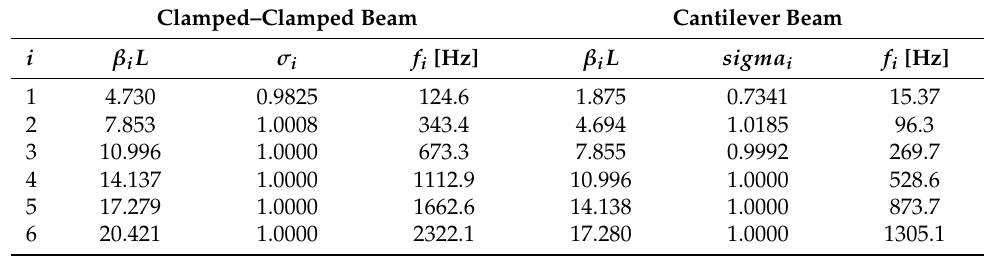
Table 1. Expected natural frequencies.